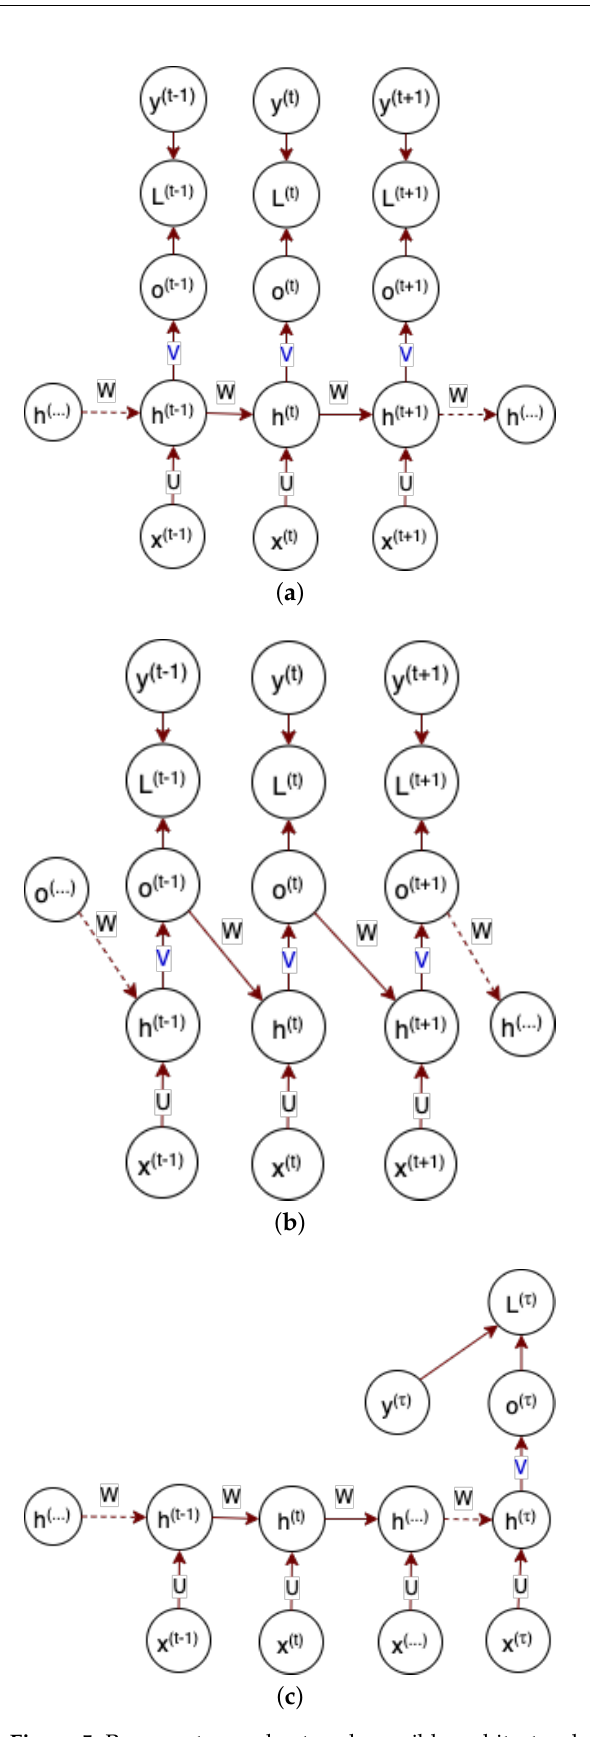
Figure 5. Recurrent neural network possible architectural